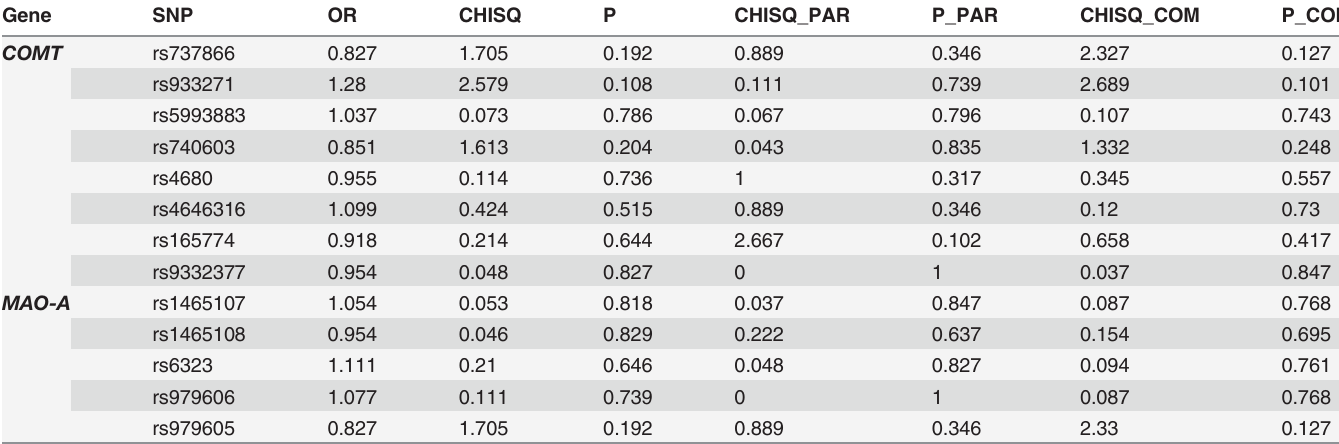
Table 3. Analysis of OCD association with catechol- O -methyltransferase and monoamine oxidase A single-nucleotide polymorphisms in male proband trios. Gene